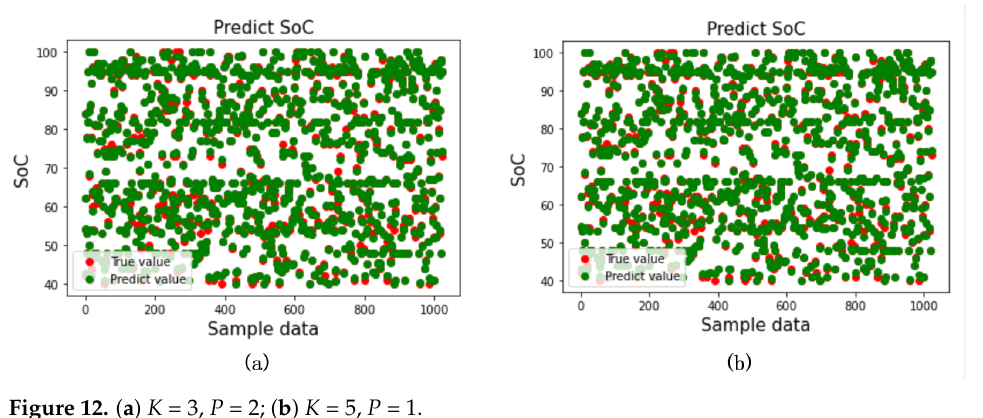
Figure 12. ( a ) K = 3, P = 2; ( b ) K = 5, P =